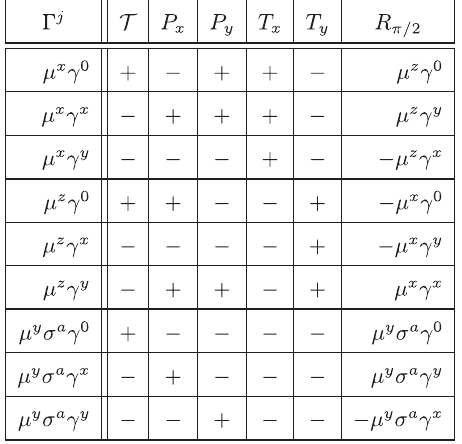
¯ X Γ j γ μ X FIG. 4. How tr ð σ a Þ transform under the physical symmetries. Γ j ¼ f μ x ; μ z ; μ y σ a g transform under the vector representation of the emergent